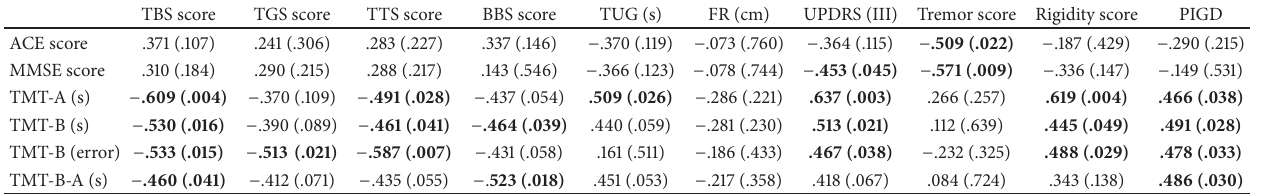
Table 5: Correlations between cognitive function, the gait and balance measures, and UPDRS derived scores for the PD group.